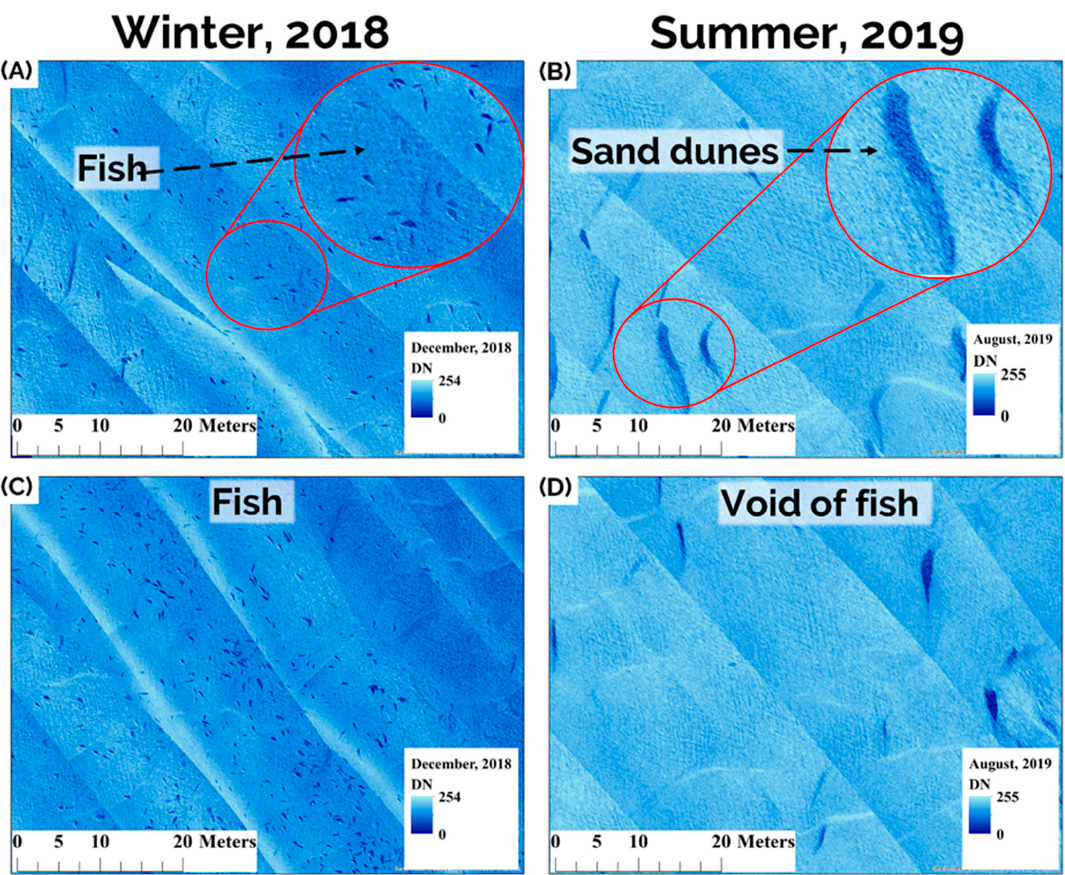
Figure 6. ( A ) A sample image from the upper extent of the Shortnose Sturgeon aggregation during winter 2018; where ‘DN’ = the digital number of the image band, and the red circle highlights a fine scale view of the identified fish. ( B ) The same reach as depicted in ( A ) from summer 2019 illustrating the image is void of fish and is dominated by sand dunes (denoted by the red circle). ( C ) A sample image from the lower extent of the aggregation during winter 2018, where fish are clearly visible. ( D ) The same reach as ( C ) during summer 2019, where the image is similarly void of fish.